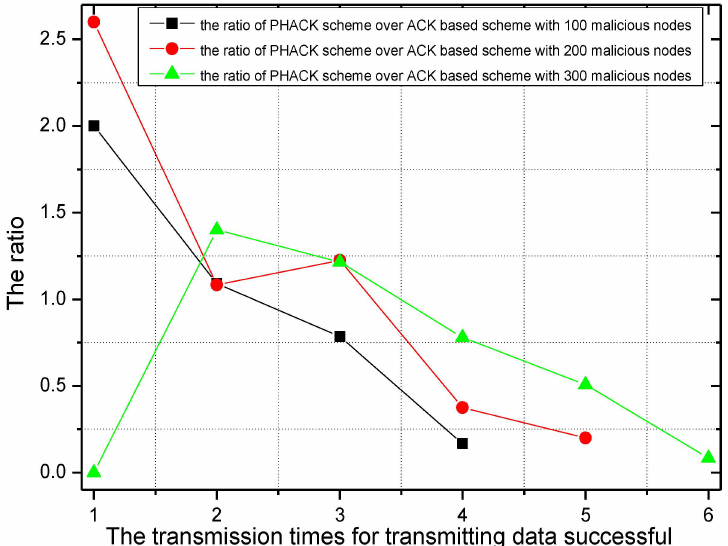
Figure 13. The ratio of transmission times for successful data transmissionof PHACK over that of the ACK-based